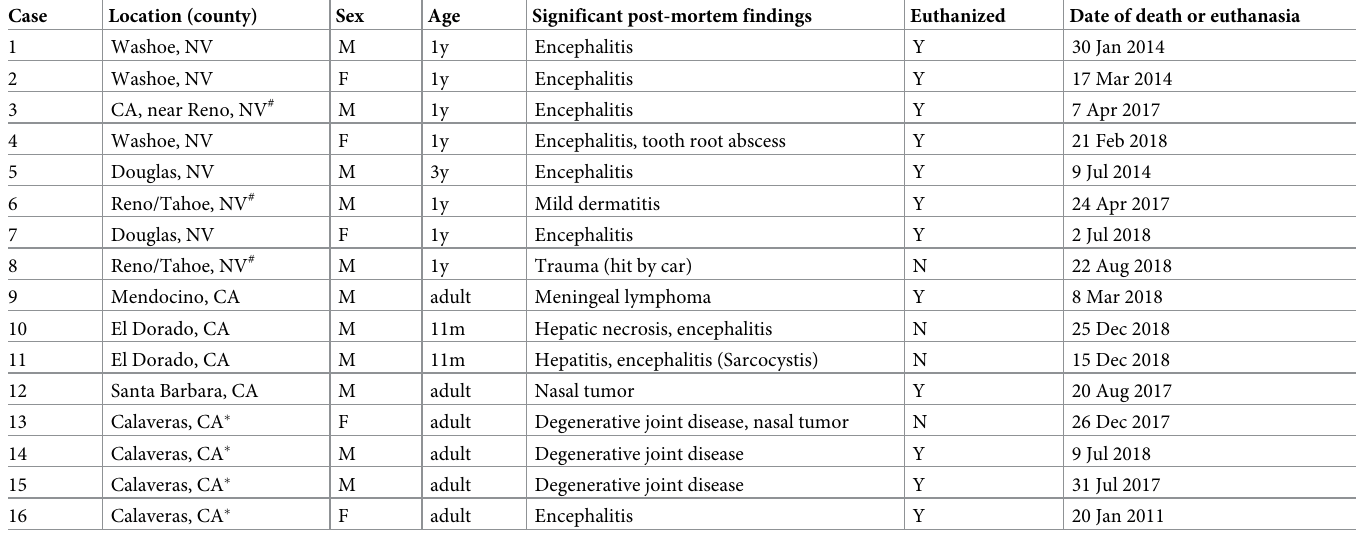
Table 1. American black bear cases included in this